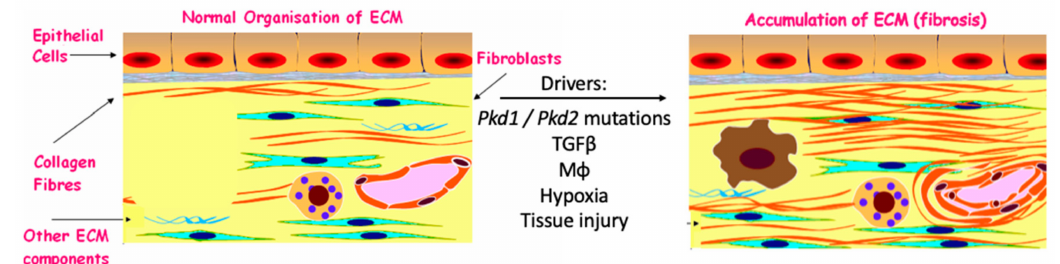
Figure 1. From normal to fibrotic interstitium. The ECM is a dynamic sca ff old that is responsible for arranging cells and cell behaviour. Type I collagen is the most abundant collagen in our body. Under normal conditions a small number of collagen fibers is present in the kidney, but when the kidney is injured, there is an excessive accumulation of fibrillar collagens, contributing to tissue scarring. Some of the drivers of tissue injury and fibrosis in the polycystic kidney, such as macrophages (M ϕ ), will be described in more detail